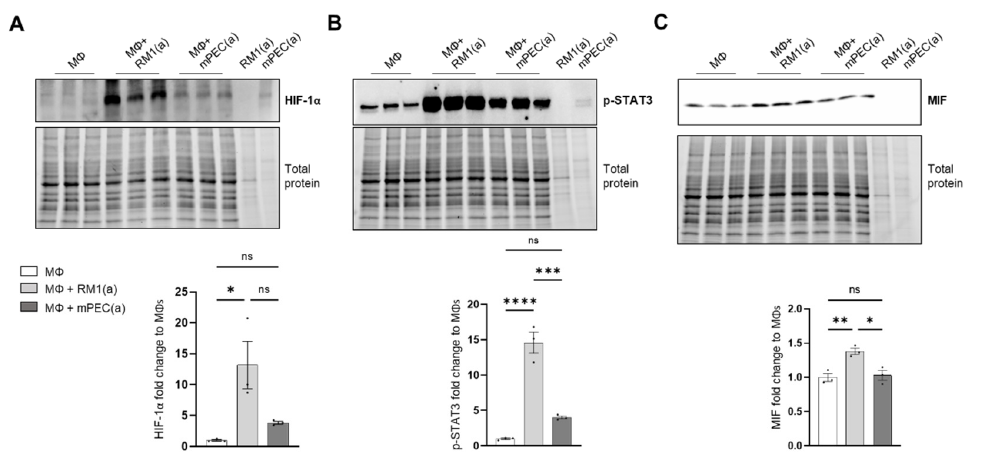
Figure 4. HIF-1 α , p-STAT3, and MIF expression is increased in apoptotic RM1-efferocytic BM macrophages. BM macrophages (M Φ ) were isolated from 4 wk old C57BL/6J mice and co-cultured with apoptotic RM1(a) or mPEC(a) cells for 16–18 h. ( A – C ) Western blot analysis of protein lysates using HIF-1 α , p-STAT3 and MIF antibody ( n = 3). Plotted data are shown as mean ± SEM, * p < 0.05, ** p < 0.01, *** p < 0.001, **** p < 0.0001, ns = not significant (ordinary one-way ANOVA test).